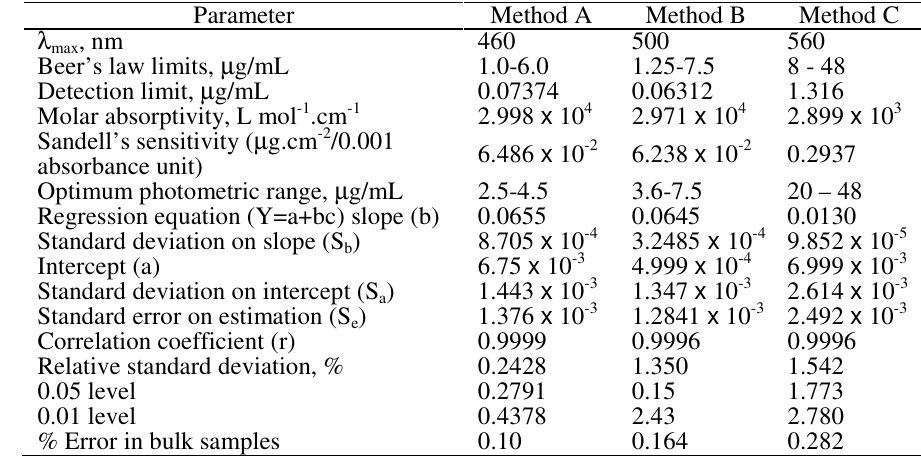
Table 2. Optical and regression characteristics, precision and accuracy of the proposed methods for PYRA Parameter